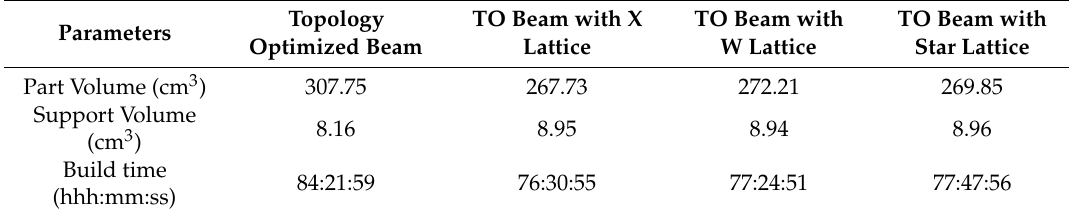
Table 3. Build parameters comparison for di ff erent lattice